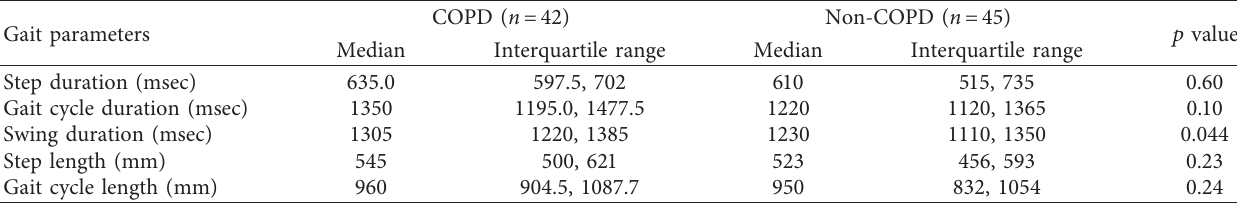
Table 2: Comparison of gait parameters between COPD and Non-COPD subjects.